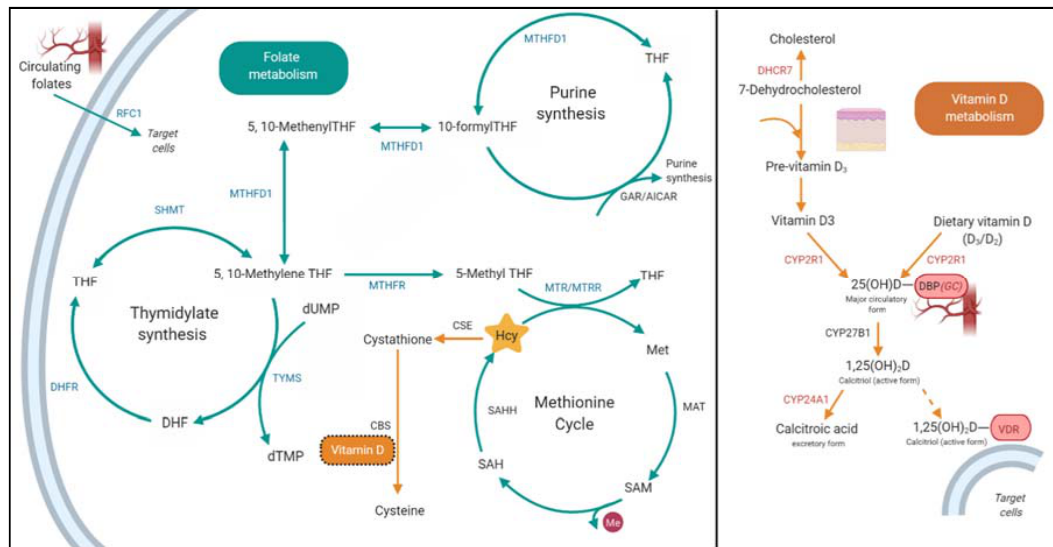
Figure 1. Examined genetic variants involved in folate and vitamin D metabolic pathways. Examined folate ‐ related genetic variants reside within key genes coding for the enzymes (blue) involved in three interconnected pathways which support activities of folate in the methionine cycle, which allows for regulation homocysteine, and pathways related to the synthesis of thymidylate (thymine precursor) and purines. These pathways are interconnected as they rely on the same pool of reduced folates within the cell, so disruption to any of these pathways via genetic variation can lead to changes in Hcy levels [4]. RFC1 is a carrier protein which transports circulating folates into target cells. Hcy may be regulated through an alternative folate ‐ independent process—the transsulfuration pathway. Hcy is converted to cysteine in this pathway via CSE and CBS. Vitamin D is previously shown to influence CBS activity [19], and this is the suggested mechanism, explaining previous reports of Hcy and vitamin D levels being inversely related [15,16]. Examined vitamin D ‐ related genetic variants reside within genes coding for the key enzymes (red) involved in vitamin D synthesis and metabolism, which may influence vitamin D levels and/or activity and therefore have the potential to influence vitamin D’s role in influencing Hcy levels. Abbreviations: Folate metabolism; AICAR, 5 ‐ aminoimidazole ‐ 4 ‐ carboxamide ribonucleotide; CBS, cystathionine beta ‐ synthase; CSE, Cystathionine gamma ‐ lyase; DHF, dihydrofolate; DHFR, dihydrofolate reductase; dTMP, deoxyuridine monophosphate; dUMP, deoxyuridine monophosphate; GAR, glycinamide ribonucleotide; Hcy, homocysteine; MAT, adenosylmethionine synthetase;